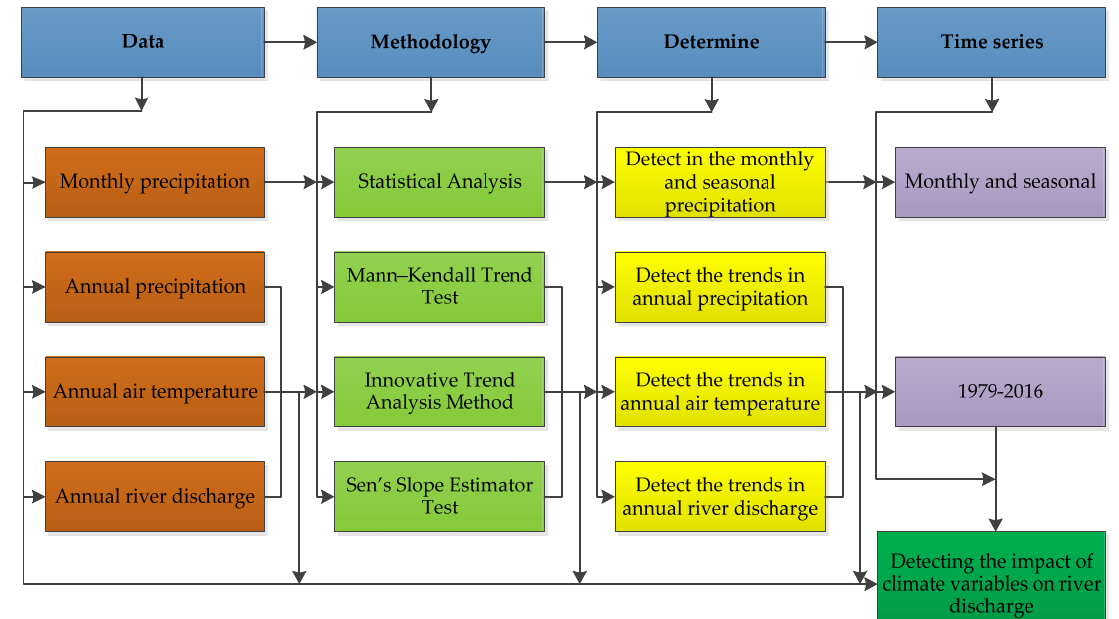
Figure 2. Workflow diagram to detect the changing trends in hydro-meteorological.